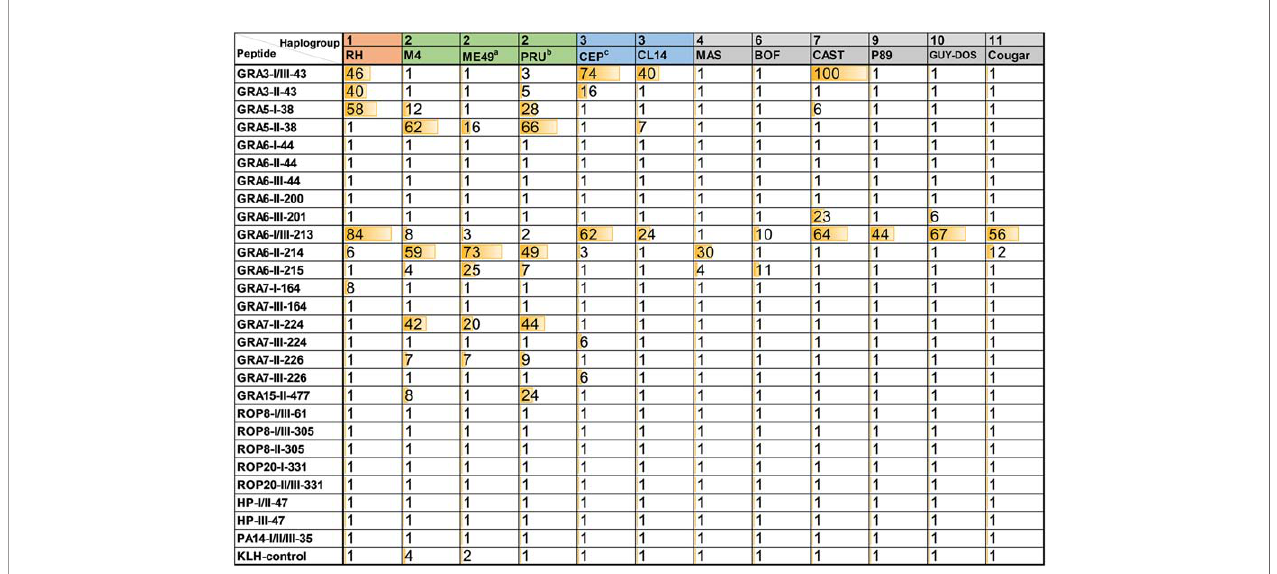
FIGURE 1 | Relative index percentage (RIPC) values for ELISAs using Toxoplasma peptides and murine sera. OD values for each sample and peptide were normalized by calculating a relative index percentage (RIPC) with the following formula RIPC = (peptide OD 405 sample – peptide OD 405 negative control)/(lysate OD 405 sample – lysate OD 405 negative control) × 100. To use a more stringent normalization, constant OD values corresponding to two times the average of the ODs obtained with the negative sample for all peptides and the lysate (0.39 and 0.25, respectively) were used. In addition, RIPC values below 1 (including negative values) were converted to 1, and those higher than 100 were converted to 100. a average of 2 ME49 samples; b average of 7 PRU samples; c average of 6 CEP